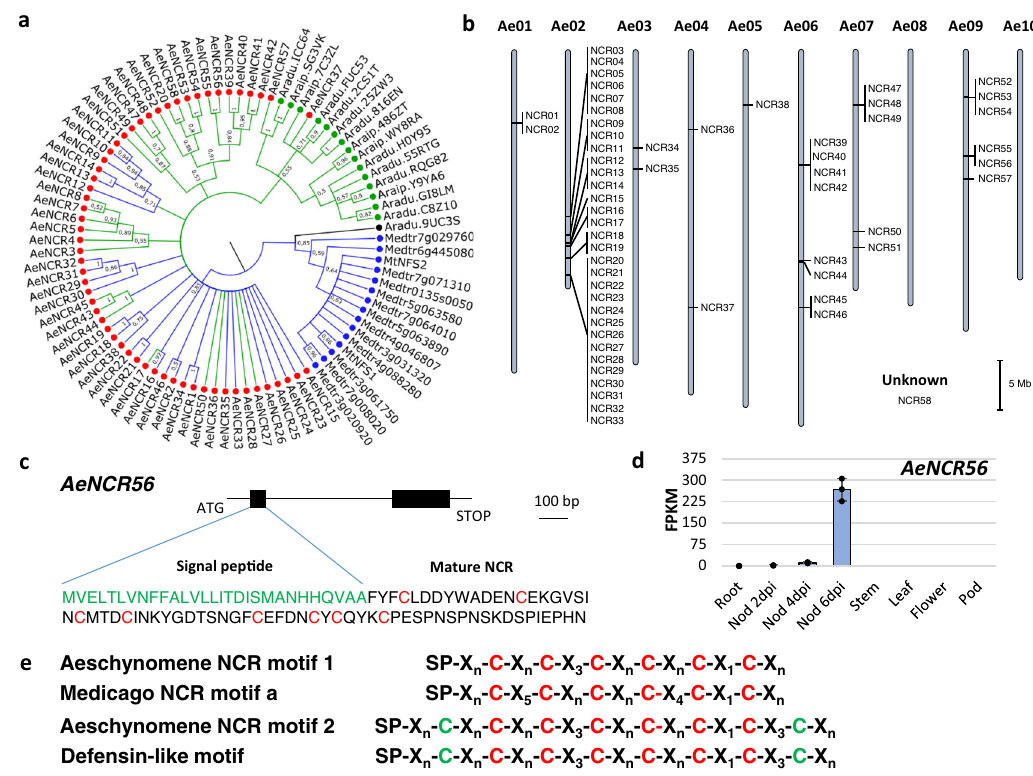
Fig. 4 NCR genes in the Aeschynomene evenia genome. a Bayesian phylogenetic reconstruction of relationships between NCR genes identi fi ed in the genomes of A. evenia (red), A. duranensis, and A. ipaiensis (green) and with a few members of M. truncatula (blue). Branches in blue correspond to NCRs with the cysteine-rich motif 1 and branches in green correspond to NCRs with the cysteine-rich motif 2. Node numbers indicate posterior probabilities. The scale bar represents substitutions per site. b Genome scale organization of NCR genes in A. evenia visualized with the SpiderMap tool. Vertical bars indicate gene clusters. c Typical structure of an NCR gene in A. evenia as exempli fi ed with AeNCR56 . Black boxes represent exons, the fi rst one coding for the signal peptide (green) and the second one for the mature NCR (with conserved cysteines in red). d Expression pattern of AeNCR56 in A. evenia aerial organs, in roots, and in nodules (Nod) after 2, 4, and 6 days post-inoculation (dpi) with the Bradyrhizobium strain ORS278. Expression is given in normalized FPKM read counts. For root and nodule samples, data correspond to mean values of three biological replicates ± SEM and dots represent individual expression levels. e Cysteine-rich motifs 1 and 2, Medicago NCR, and defensin structures 33 . SP, signal peptide, Xn, length of conserved spacing between cysteines. In red, conserved cysteines in motif 1; in green, additional cysteines found in motif 2 and shared with the defensin signature. Source data underlying ( b , d ) are provided as a Source Data fi